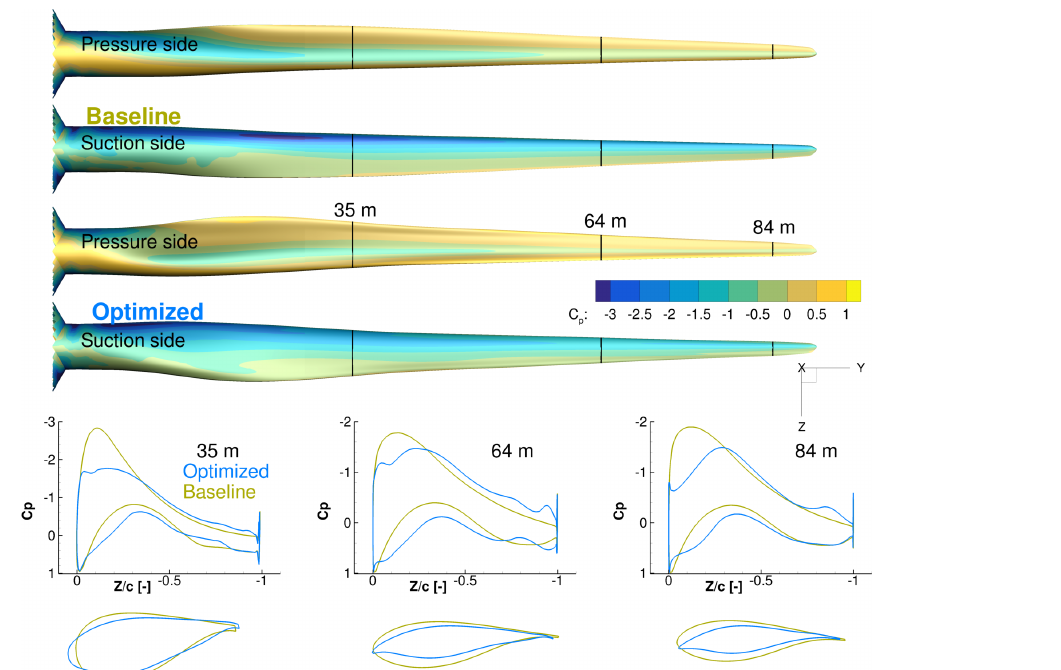
Figure 15. Comparison of C p distributions for the baseline and optimized result from the single-point shape optimization. There is an increase in TE camber, especially at the root, as well as a less pronounced suction peak.